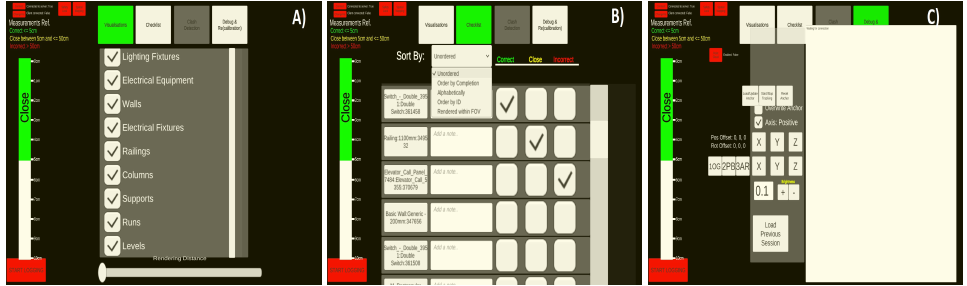
Figure 4. The left image ( A ) presents the UI design for the visualisations tab; image ( B ) displays the UI design for the checklist tab where a dynamic checklist of each element within the BIM model was generated; image ( C ) presents the UI design for the diagnostics